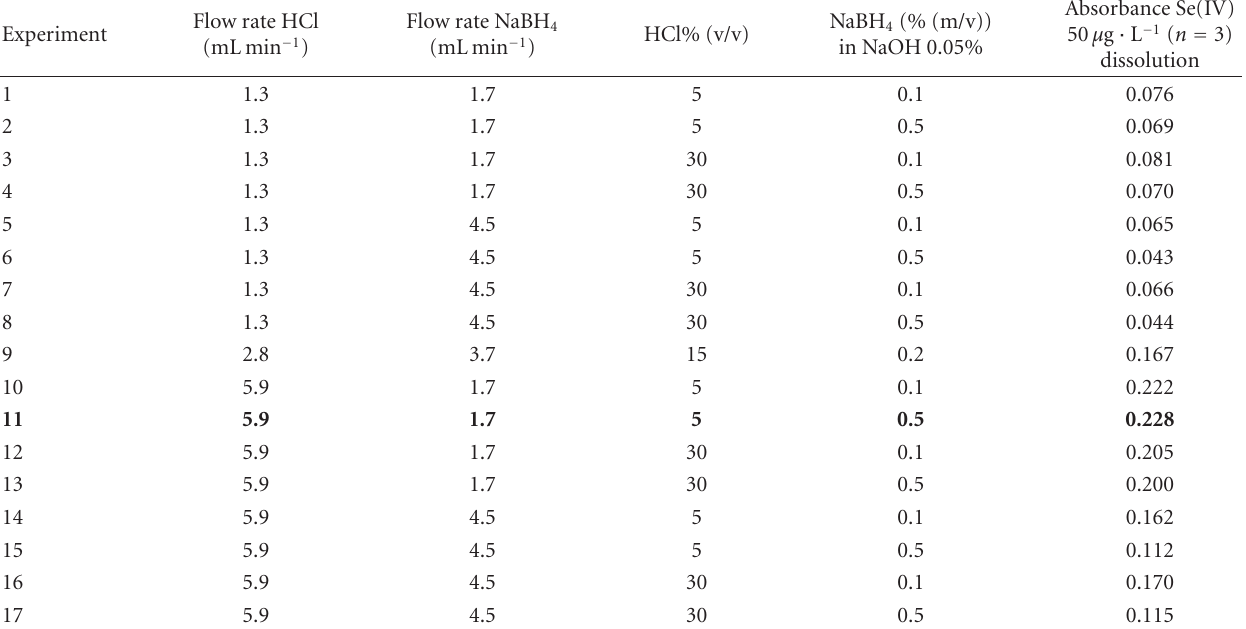
Table 3: Central composite experimental design, 4 variables and 3 levels.